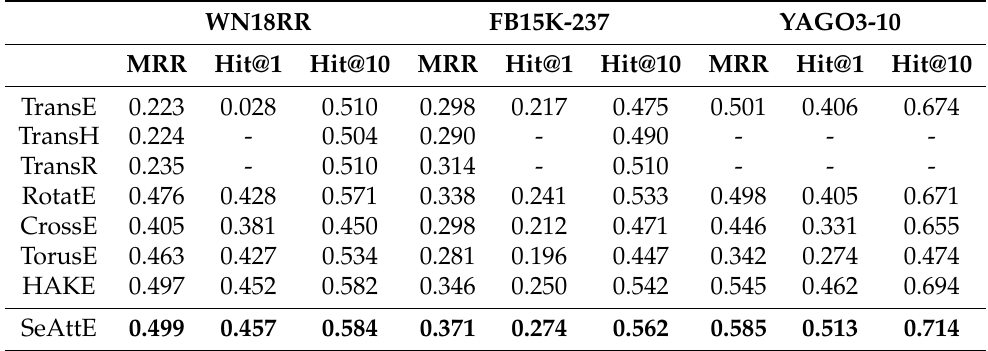
Table 2. This is the comparison between SeAttE and geometric models on WN18RR, FB15K-237 and YAGO3-10. The best results of each metric for each dataset are marked in bold.